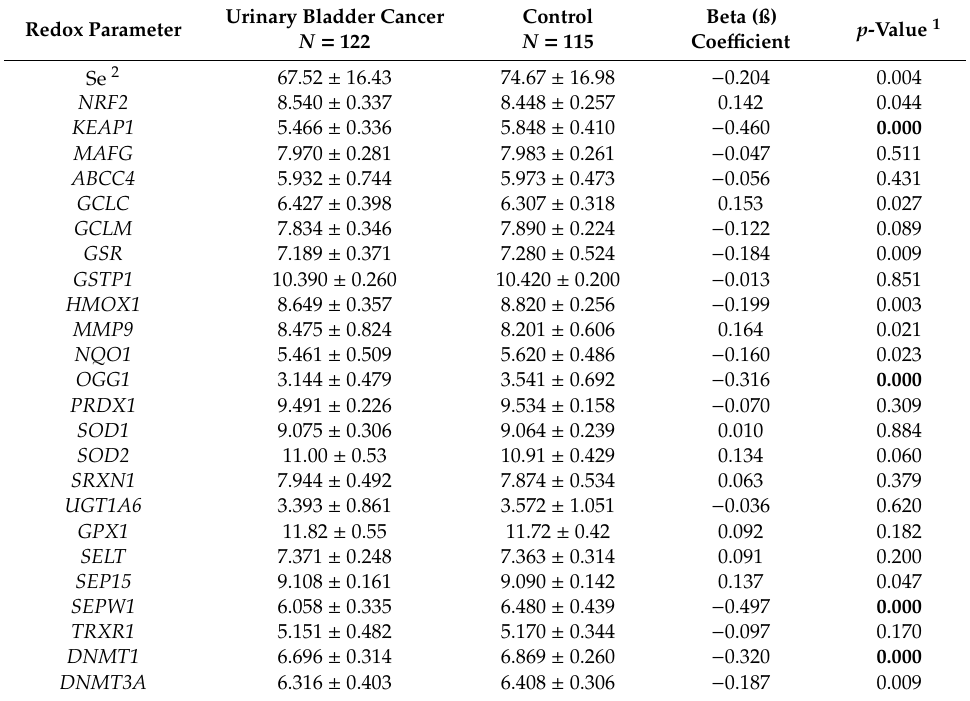
Table 2. Redox status in the blood of the Urinary bladder cancer patients and the controls. Redox